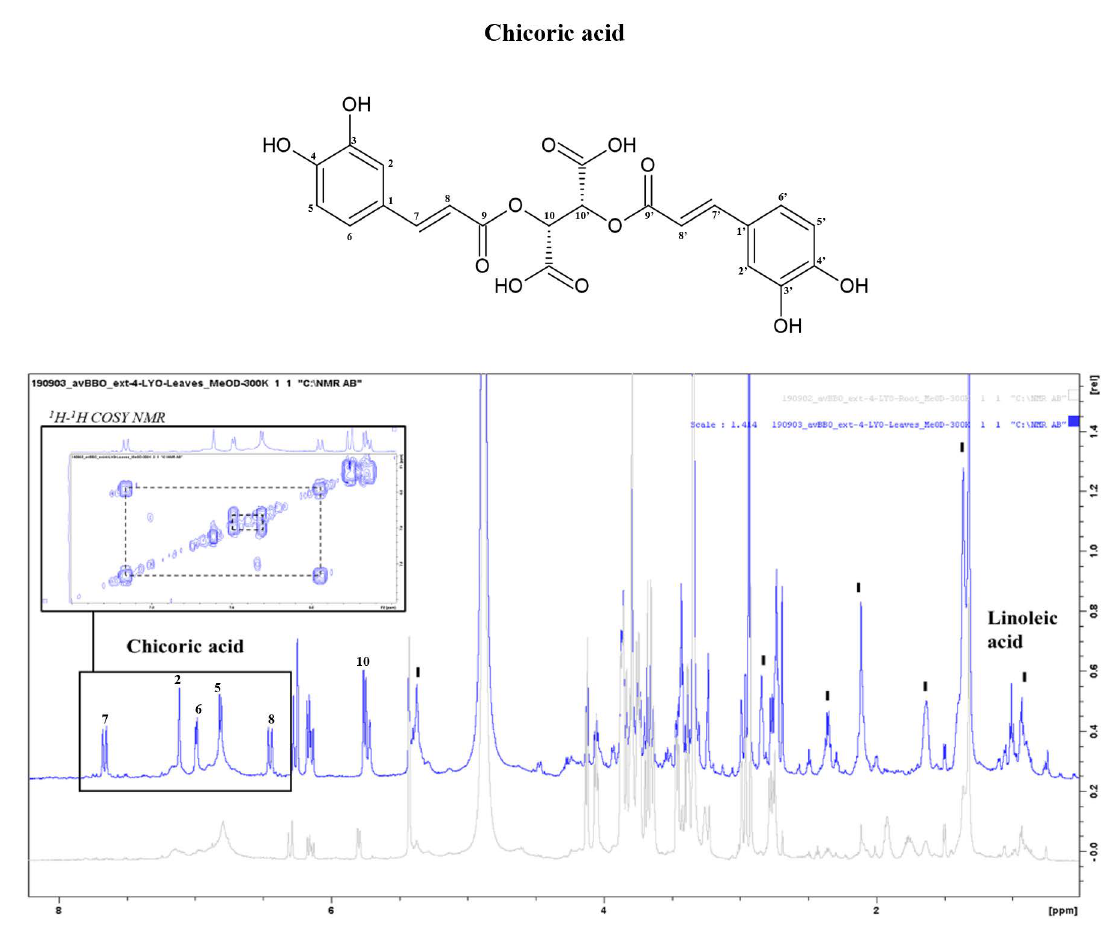
Figure 5. NMR spectra of Posidonia oceanica leaf extracts (MeOH 100% extraction) (blue signal) in comparison with root extracts (grey